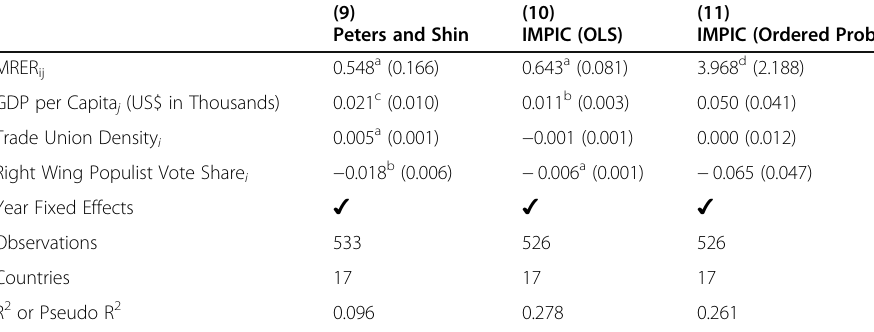
Table 3 Immigrant rights – alternative dependent